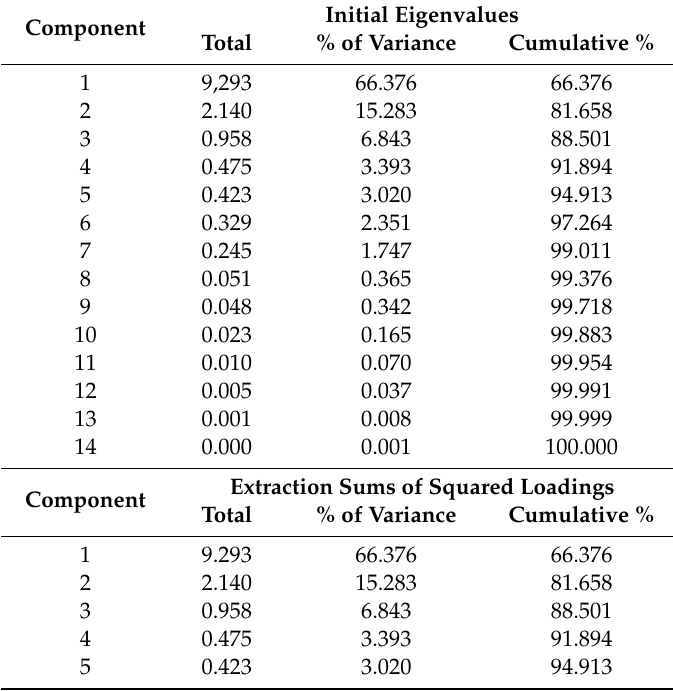
Table 3. Contribution matrix of principal component analysis of the eigen quantities of 14 dimensions. When the dimensions are reduced to five to reconstruct the eigen signals, the loss quantity shows an inflection